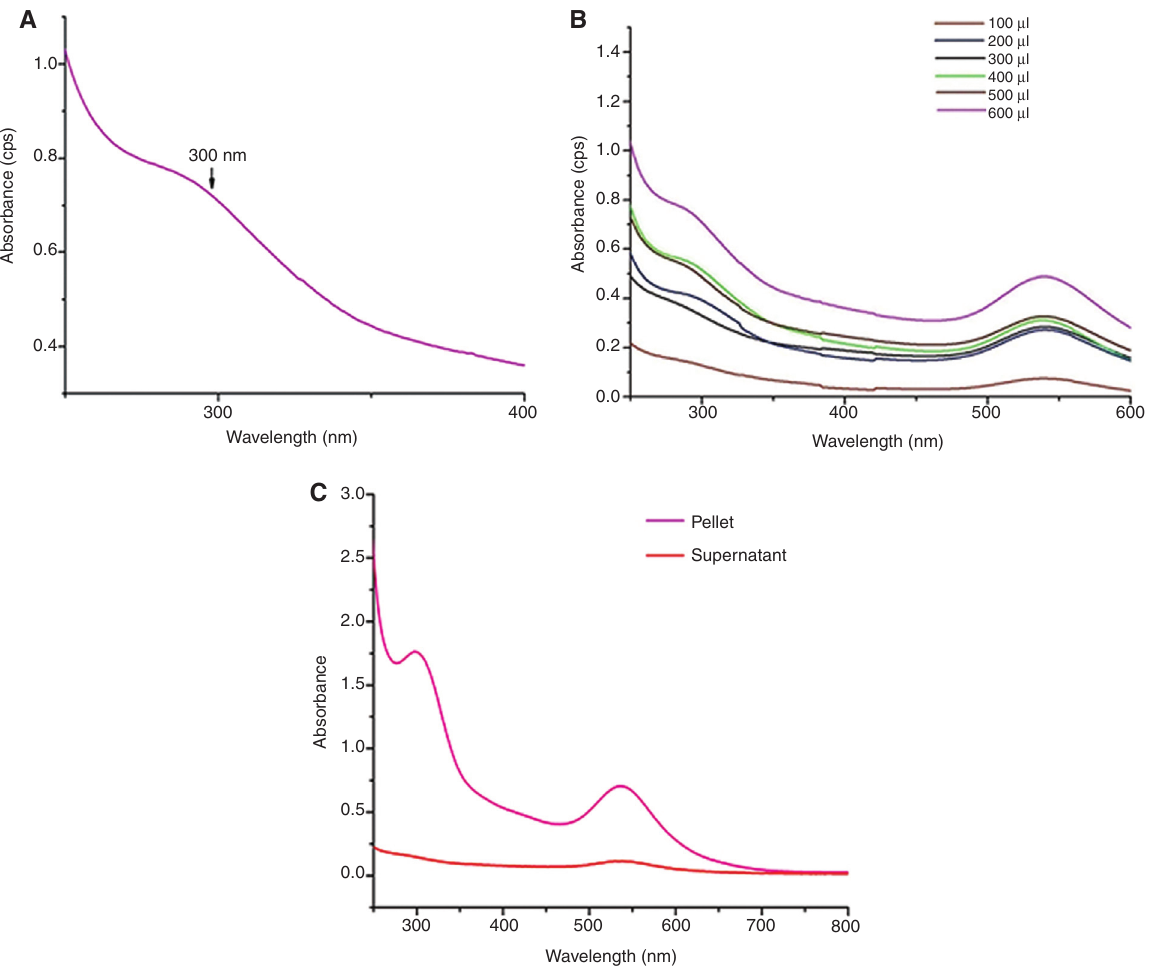
Figure 4 UV spectra of (A) polyethylene glycol (PEG), (B) PEGylated gold nanoparticles, (C) functionalized nanoparticles-supernatant and